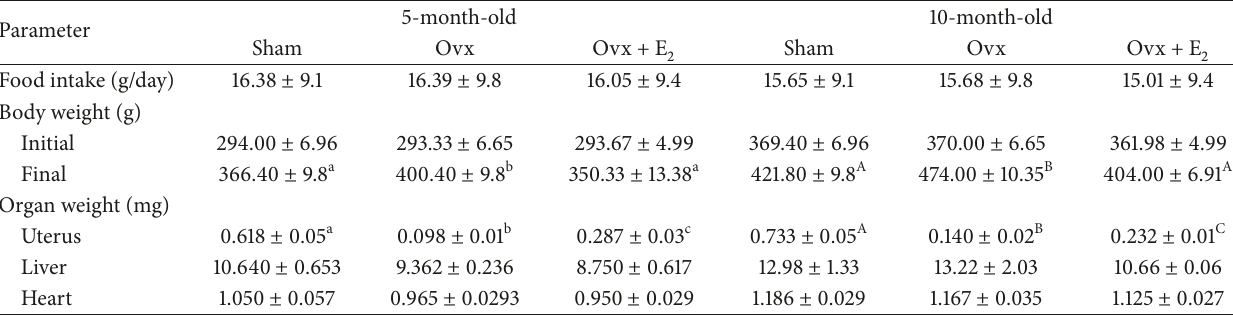
Table 1: The effects of ovariectomy (ovx) and 17 𝛽 -estradiol (ovx + E 2 ) on food intake, body, and organ weight in rats with initial ages of five and ten months. Despite pair-feeding the animals, ovariectomy significantly increased body weight and caused atrophy of uterine tissue without any effects on heart or liver weights.